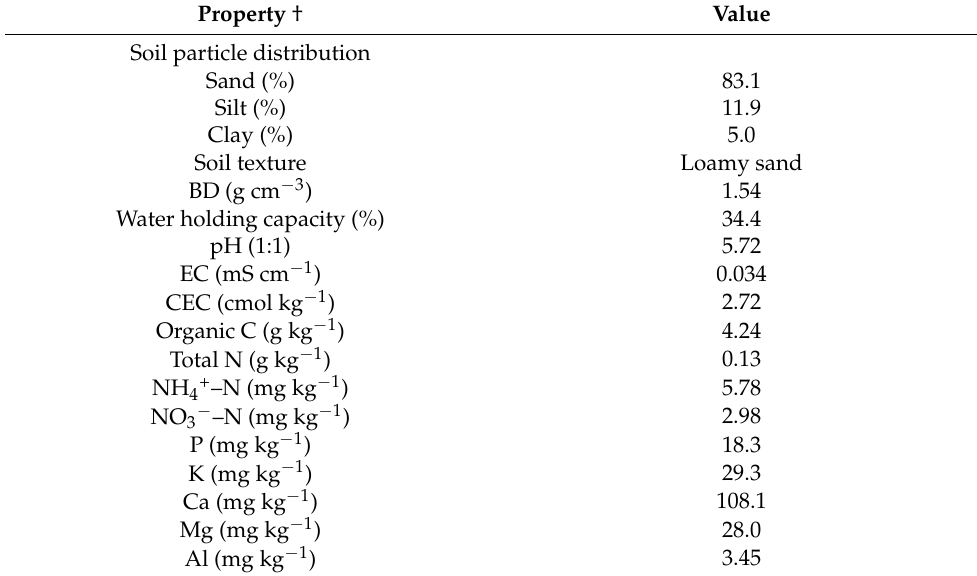
Table 1. Initial soil properties.